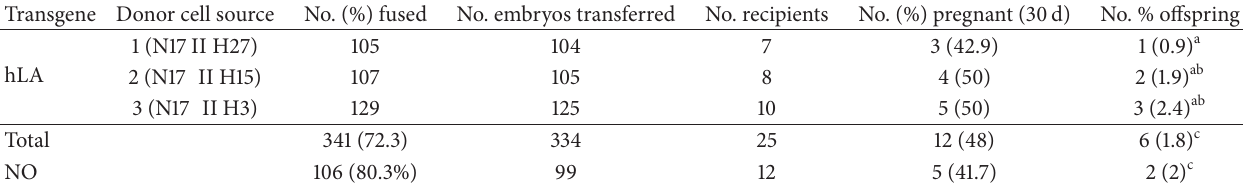
Table 1: Production of transgenic cloned goats.